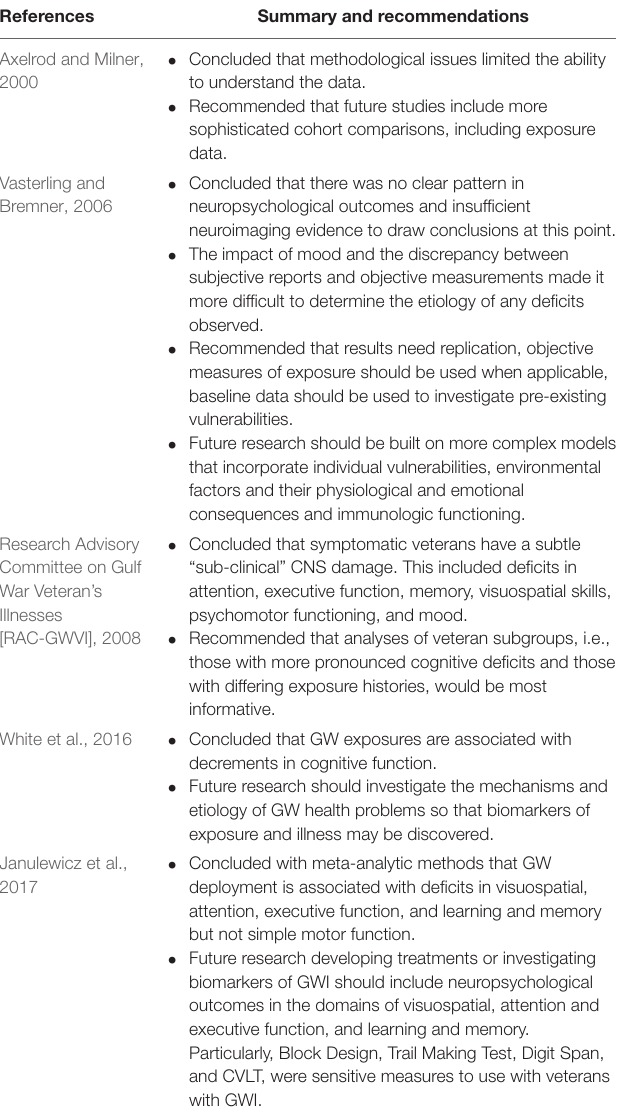
TABLE 2 | Review papers on neuropsychological